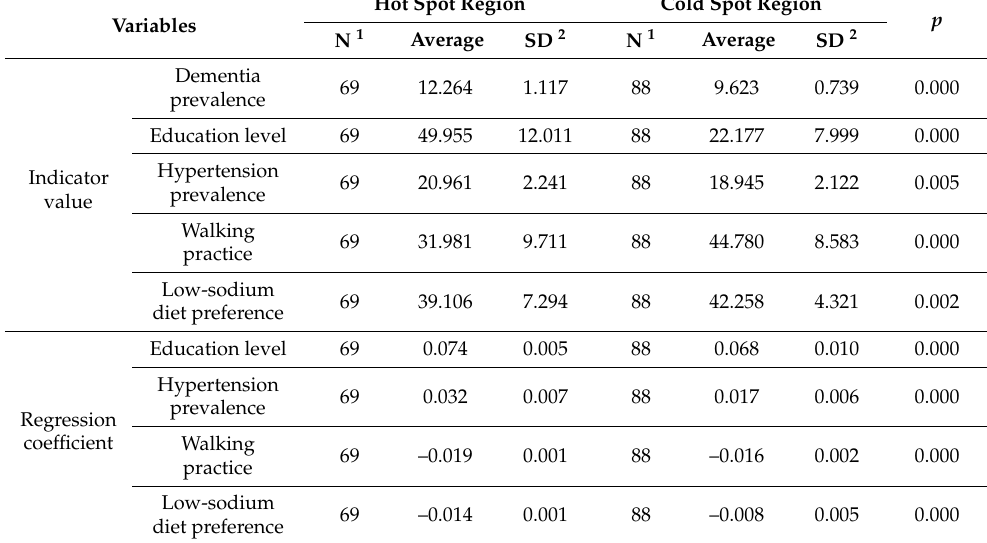
Table 4. Differences in risk factors for dementia prevalence in hot spot and cold spot regions.